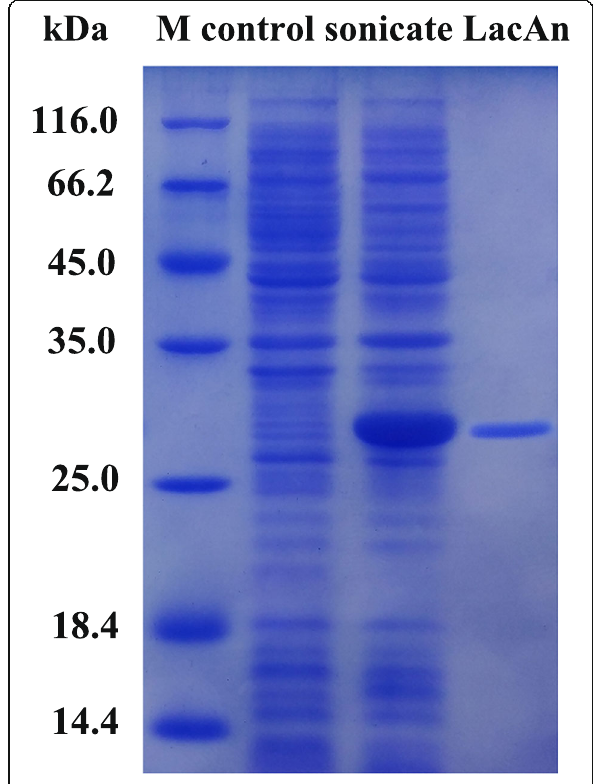
Fig. 2 SDS-PAGE of overexpressed and Ni 2+ -NTA purified LacAn. Lane M, standard molecular weight marker; lane control, BL21(DE3) without pET22b-lacAn; lane sonicate, sonication product precipitate of BL21(DE3)-pET22b-lacAn; lane LacAn, purified